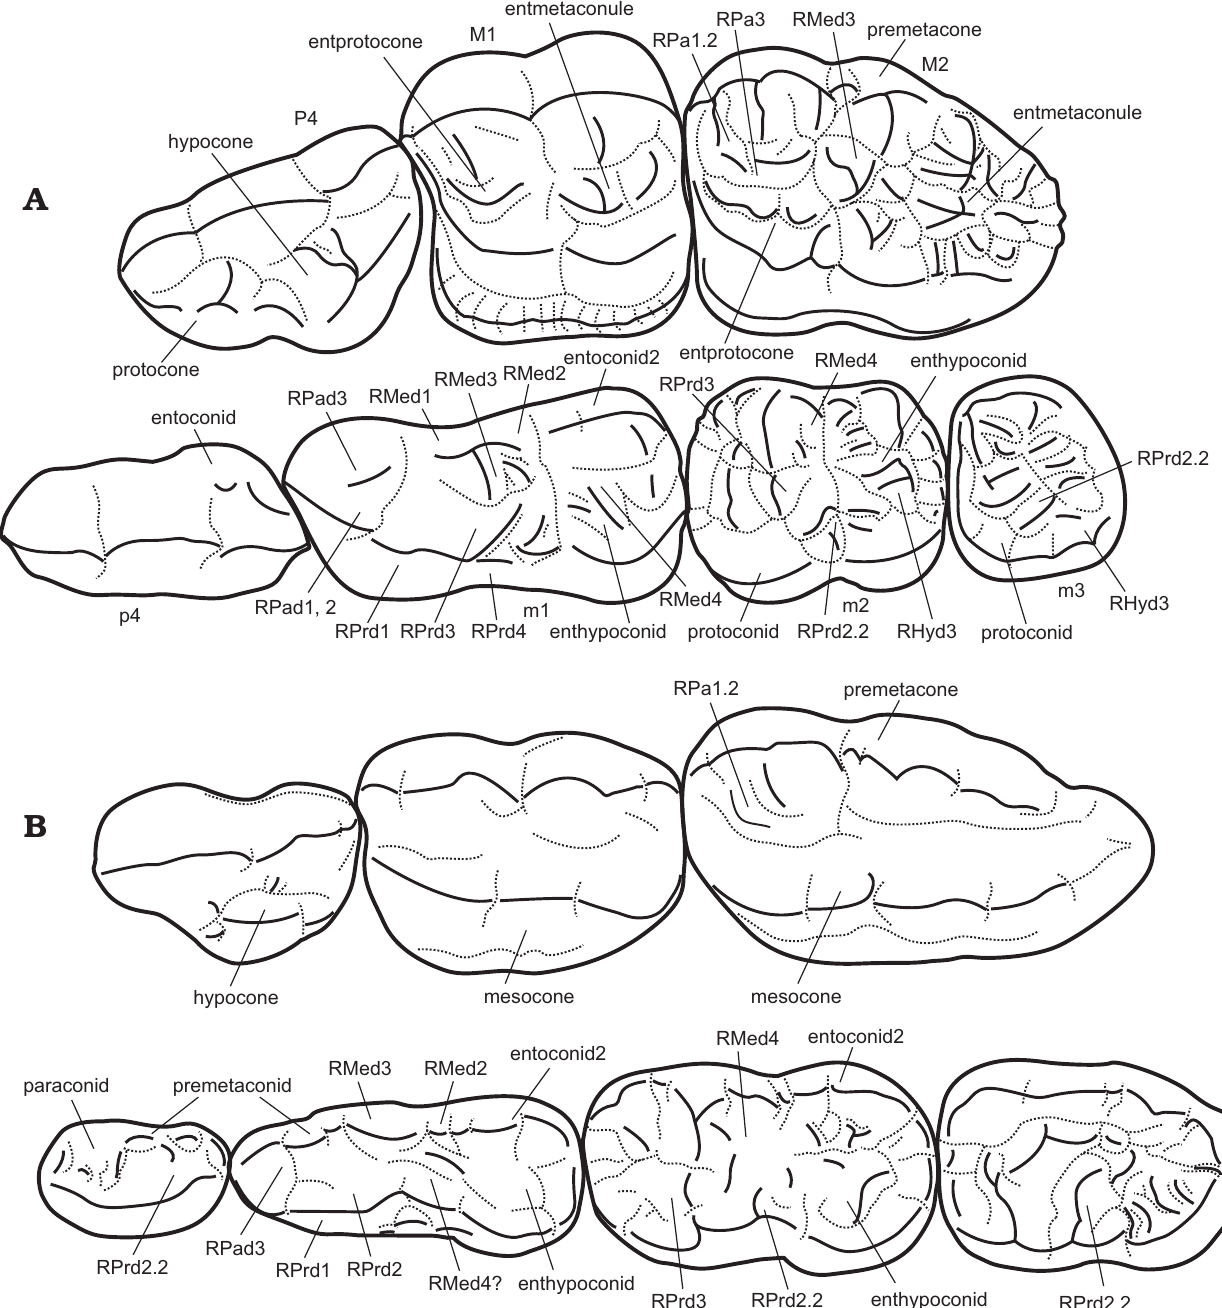
Fig. 2. Illustrations of proposed terminology of teeth of giant panda Ailuropoda melanoleuca ( A ) and cave bear Ursus deningeri ( B ). Abbreviations: RHyd3, medial ridge of protoconid; RMed1, anterior ridge of metaconid; RMed2, posterior ridge of metaconid; RMed3, medial ridge of metaconid; RMed4, poste- ro-medial ridge of metaconid; RPad1, anterior ridge of paraconid; RPa1.2, medial branch of anterior ridge of paracone; RPad1, anterior ridge of paraconid; RPad2, posterior ridge of paraconid; RPa3/RPad3, medial ridge of paracone/paraconid; RPrd1, anterior ridge of protoconid; RPrd2, posterior ridge of pro- toconid; RPrd2.2, medial branch of the posterior ridge of protoconid; RPrd3, postero-medial ridge of protoconid; RPrd4, postero-lateral ridge of